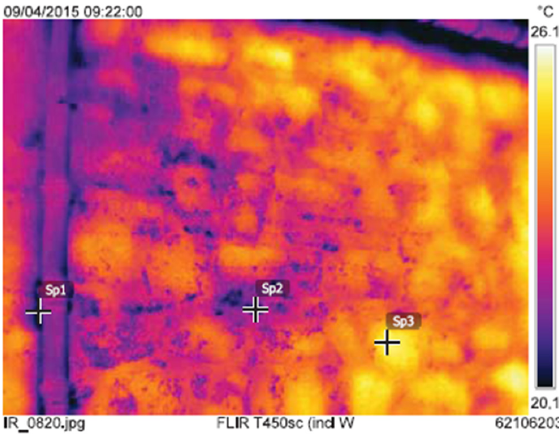
Figure 7. Exterior wall, North ‐ East oriented.